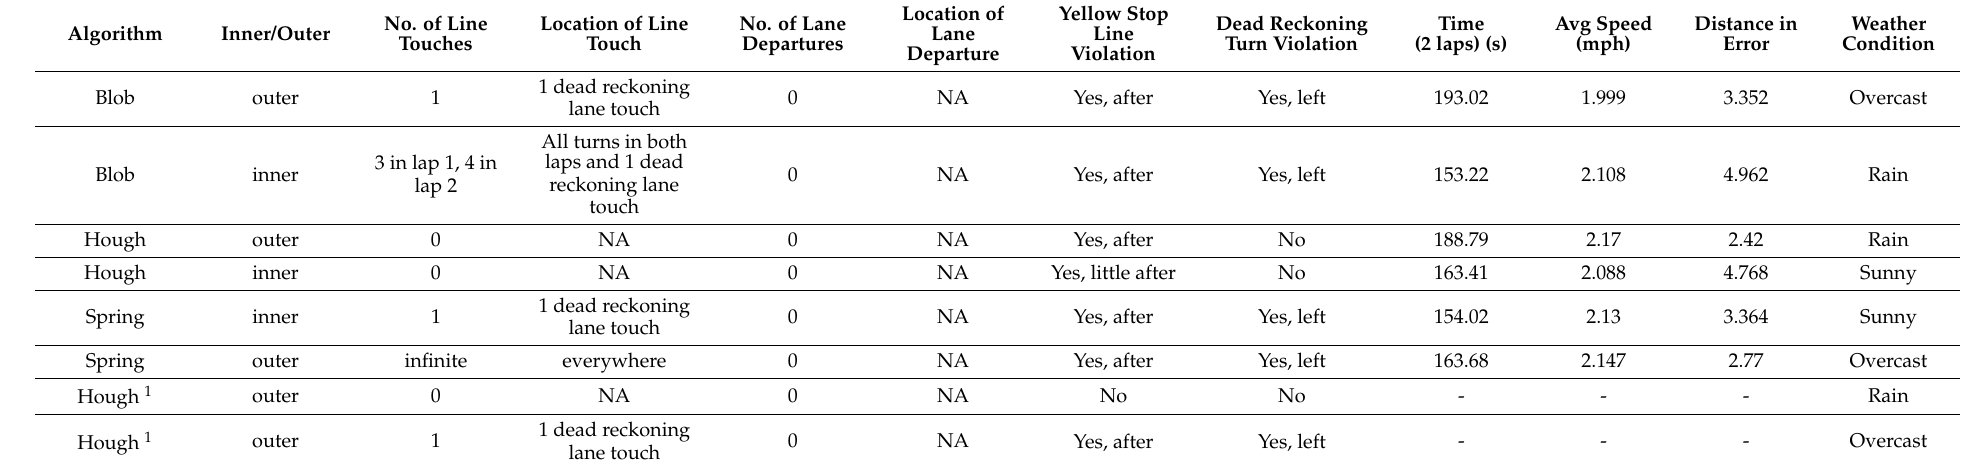
Table A1. Success Cases on the official test